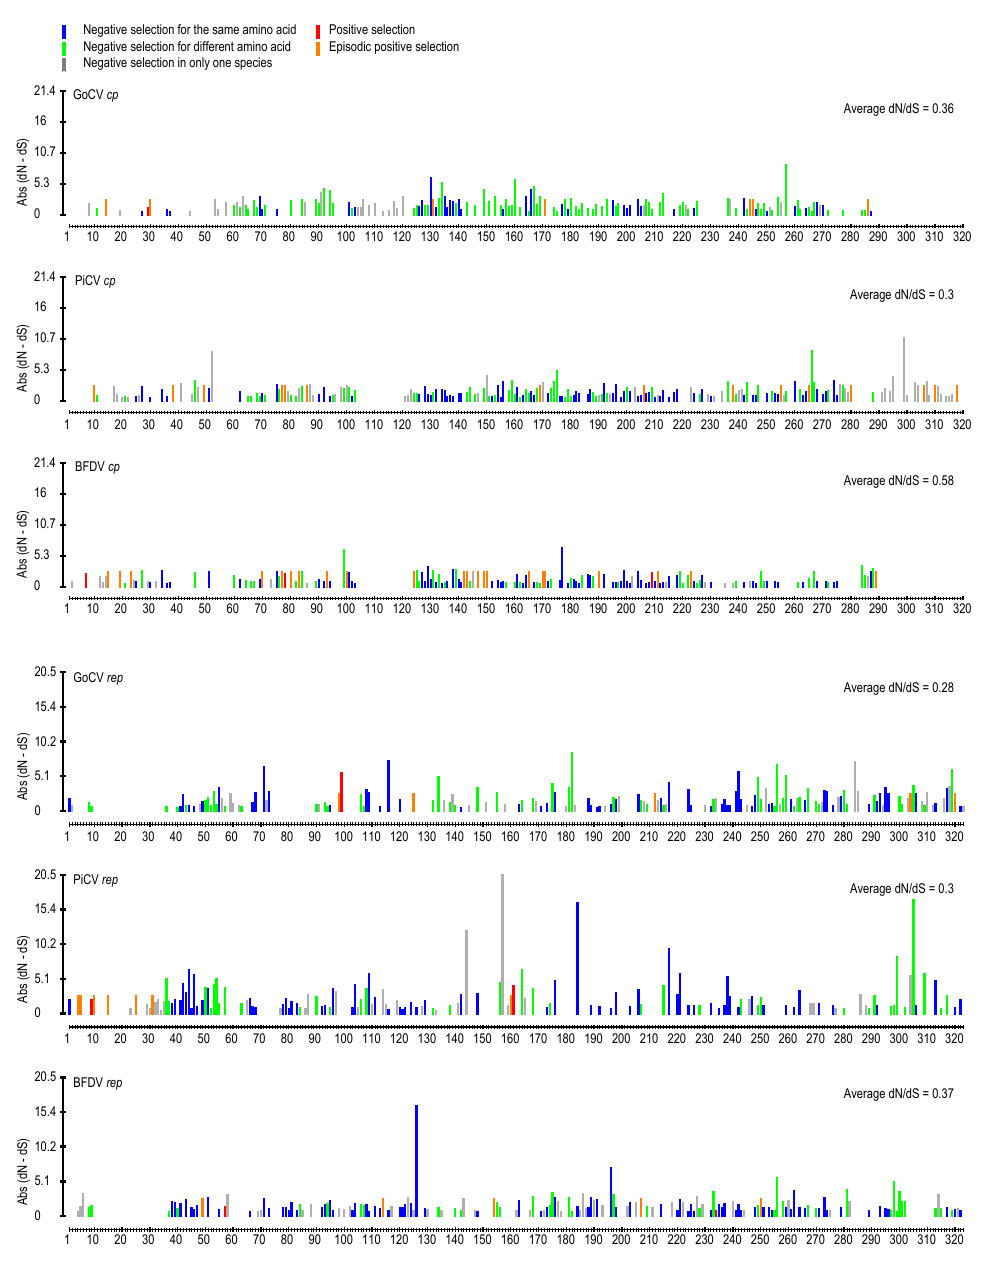
Figure 3. Patterns of natural selection acting at cp and rep codon sites in beak and feather disease viruses (BFDV), GoCV, and pigeon circovirus (PiCV) genomes. Presented here are schematic representations of aligned rep and cp codon sites where, for each site, absolute (Abs) values of inferred synonymous substitution rates subtracted from inferred non-synonymous substitution rates (dN-dS) are plotted (as determined by the FUBAR method). Significantly positive dN-dS values are indicated by a red bar (indicating the strength of positive selection), and significantly negative dN-dS values are plotted in grey, green, and blue (indicating the strength of negative selection). Whereas blue colors indicate sites at which negative selection favors the same encoded amino acid in multiple different species, green colors indicate sites where negative selection favors different encoded amino acids in different species. Grey colors indicate sites at which negative selection was only detectable in a single species. Sites in orange display evidence of evolving under positive selection within particular lineages of the various species (indicated by the MEME method). Missing bars indicates gaps in the BFDV, GoCV, and PiCV gene